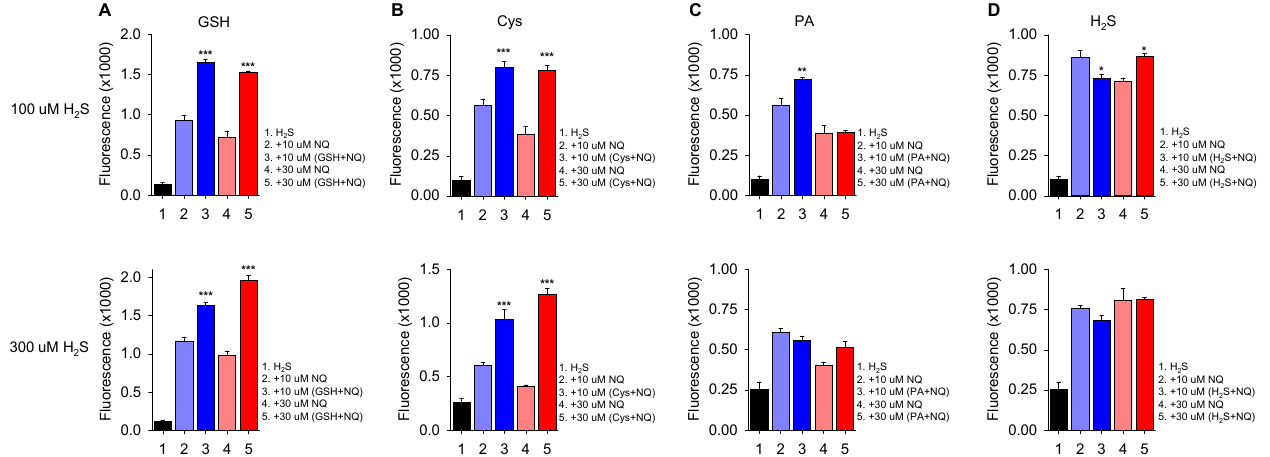
Figure 6. Polysulfide production (SSP4 fluorescence) from H 2 S catalyzed by 1,4-NQ adducts. Adducts were prepared by incubating 1 mM 1,4-NQ with 1 mM GSH ( A ), Cys ( B ), PA ( C ), or H 2 S ( D ) for 1 h then reacting 10 µ M or 30 µ M of the adduct with either 100 µ M (top panels) or 300 µ M (bottom panels) H 2 S. Polysulfide production was greatly increased by each thiol adduct but only marginally affected by the PA or H 2 S adducts; GSH adducts were the most efficacious. Values summarize effects after 90 min reaction, mean + SE, n = 4 wells; *, p < 0.05, **, p < 0.01, ***, p < 0.001 vs. 1,4-NQ without